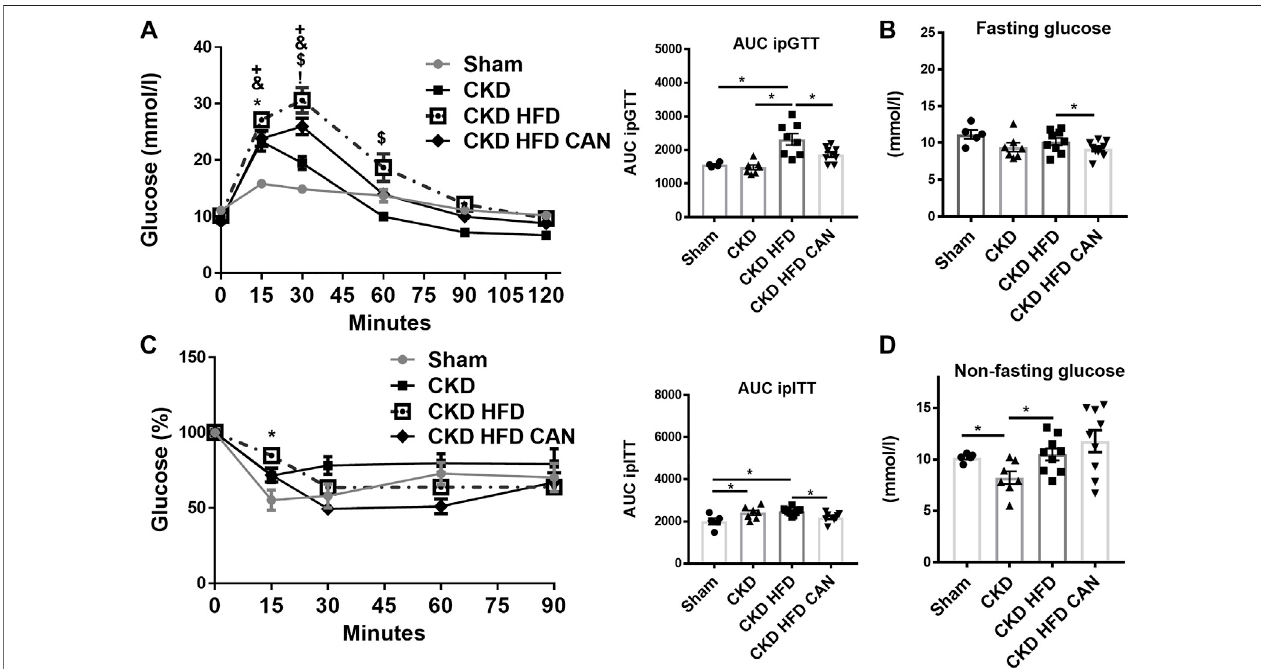
FIGURE 2 | Characterization of the metabolic impact and effect of the MRA canrenoate. Mice were subjected to a glucose tolerance test (GTT) and an insulin sensitivity test (ITT). (A) Glucose tolerance test and area under the curve (B) fasting glucose (C) Insulin tolerance test represented as a decrease of the percentage of basal glucose over time, and area under the curve, (D) non-fasting glucose. Data represent the mean ± SEM. Statistical analysis by two-way ANOVA with Sidak post- test, * p < 0.05 CKD HFD vs. Sham, # p < 0.05 CKD HFD vs. CKD, + p < 0.05 CKD HFD CAN vs. CKD HFD, & p < 0.05 CKD groups vs. Sham; and one-way ANOVA withTukeypost-test* p < 0.05,Shamvs.CKD; + p < 0.05,Shamvs.CKDHFD; & p < 0.05,Shamvs.CKDHFDCAN; $ p < 0.05,CKDvs.CKDHFD n =5 – 9; ! p < 0.05,CKD vs. CKD HFD CAN or one-way ANOVA; with Tukey post-test * p < 0.05 n = 5 – 9 for ITT and GTT AUC and panels B and